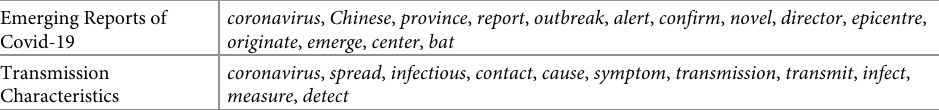
Table 2. Early pandemic topics and collocates.